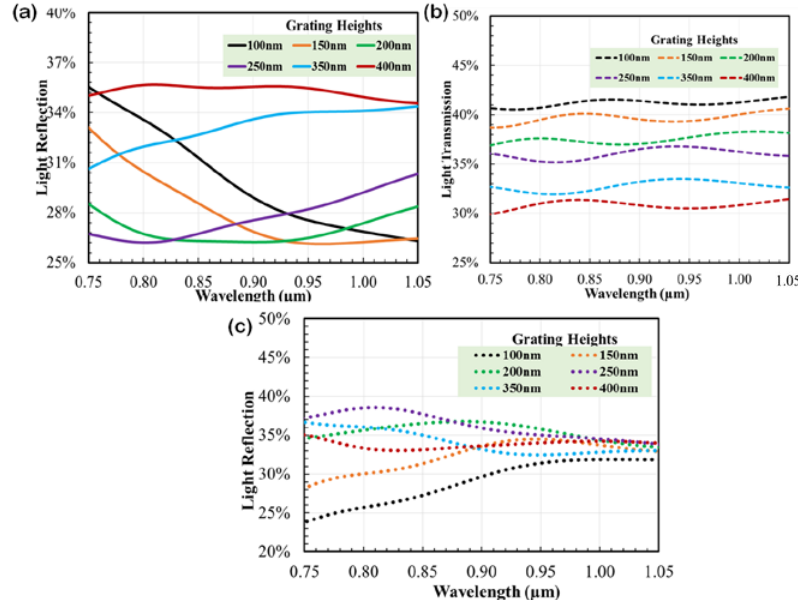
Figure 7. Observation of light reflection ( a ), transmission ( b ), and absorption ( c ) spectra for a rectangular-shaped nano-grating structure.